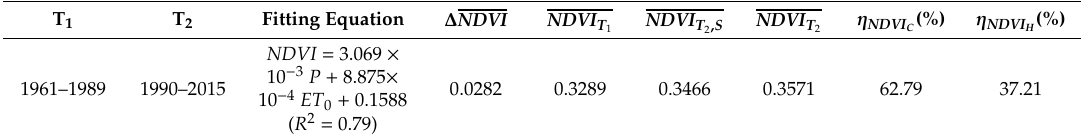
Table 1. Attribution analysis of vegetation changes in the source area of the Yellow River.